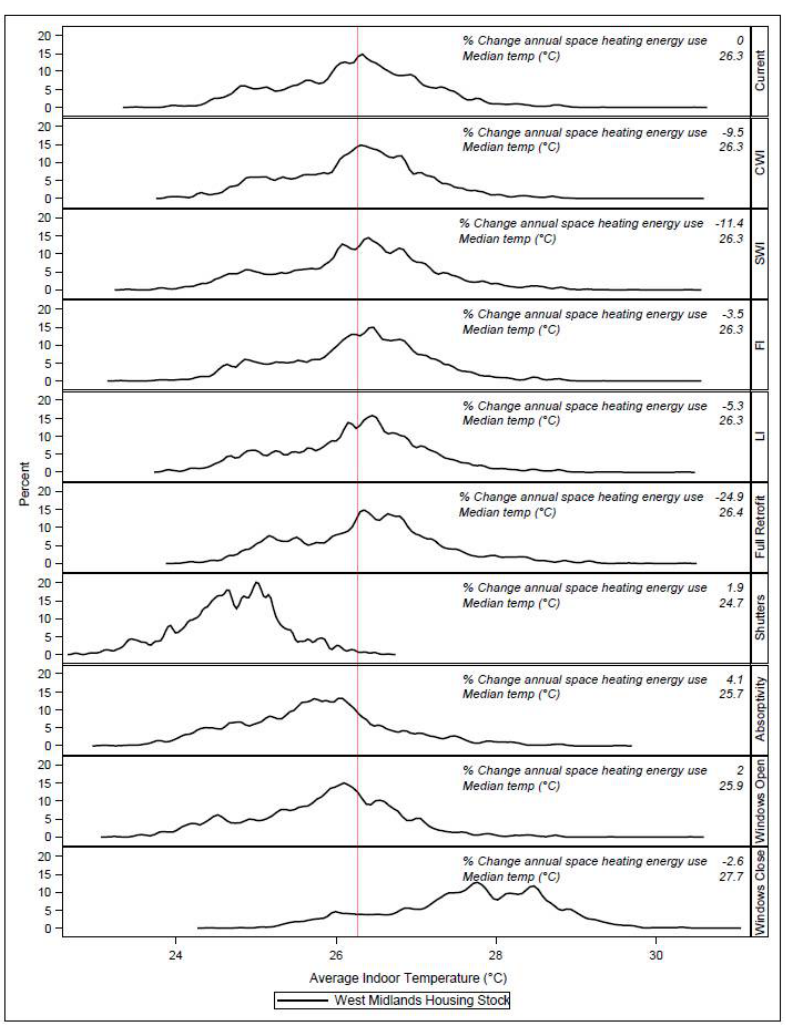
Figure 2. Density plots of the average indoor temperature when (cid:1846) (cid:3040)(cid:3028)(cid:3051),(cid:3042)(cid:3048)(cid:3047),(cid:3031) exceeds 23 °C during the 2030 summer following energy efficiency, heat, and behavioural adaptations. The red vertical line shows the median for the current (unadapted) stock (26.3